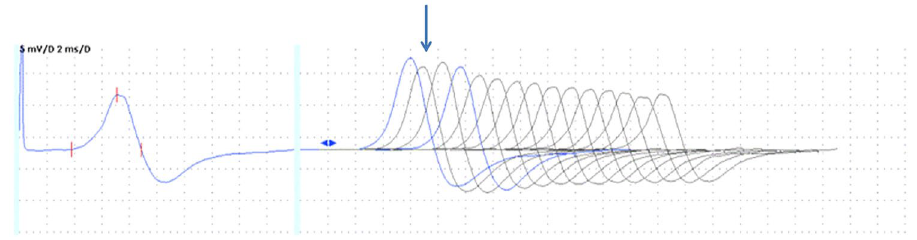
Figure 2. CMAPs evoked by repetitive nerve stimulation (RNS) of the tibial nerve at a high frequency (50 Hz). The decrement-increment phenomenon is indicated by the